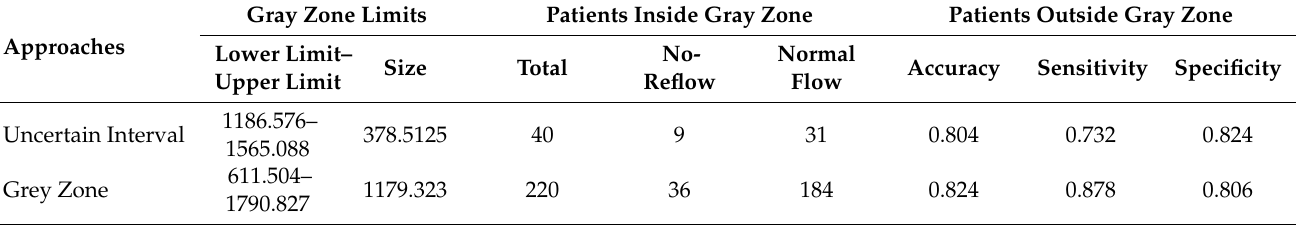
Table 4. The Results for Approaches to Gray Zone Identification.